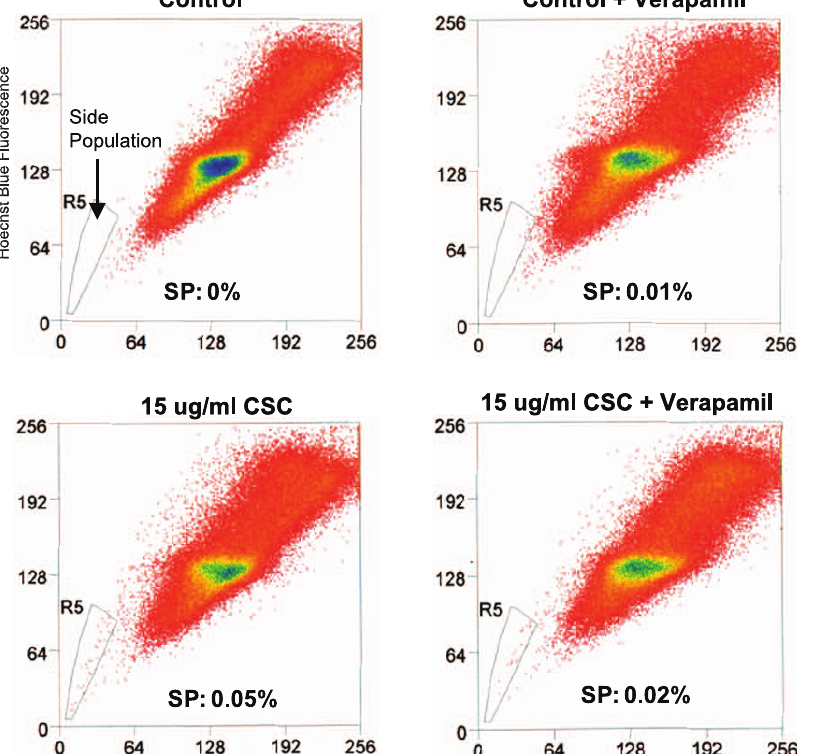
Figure 7. CSC treatment increases the side population in 10B cells. FACS-based Hoechst extrusion assay shows the size of side population (SP) in 10B cells incubated with two doses of CSC. The size of the SP increases with increasing dosage of CSC. Cells were incubated in 5 ug/ml of Hoechst for 90 min and then in DMEM w/CSC or normal DMEM for 24 hours.